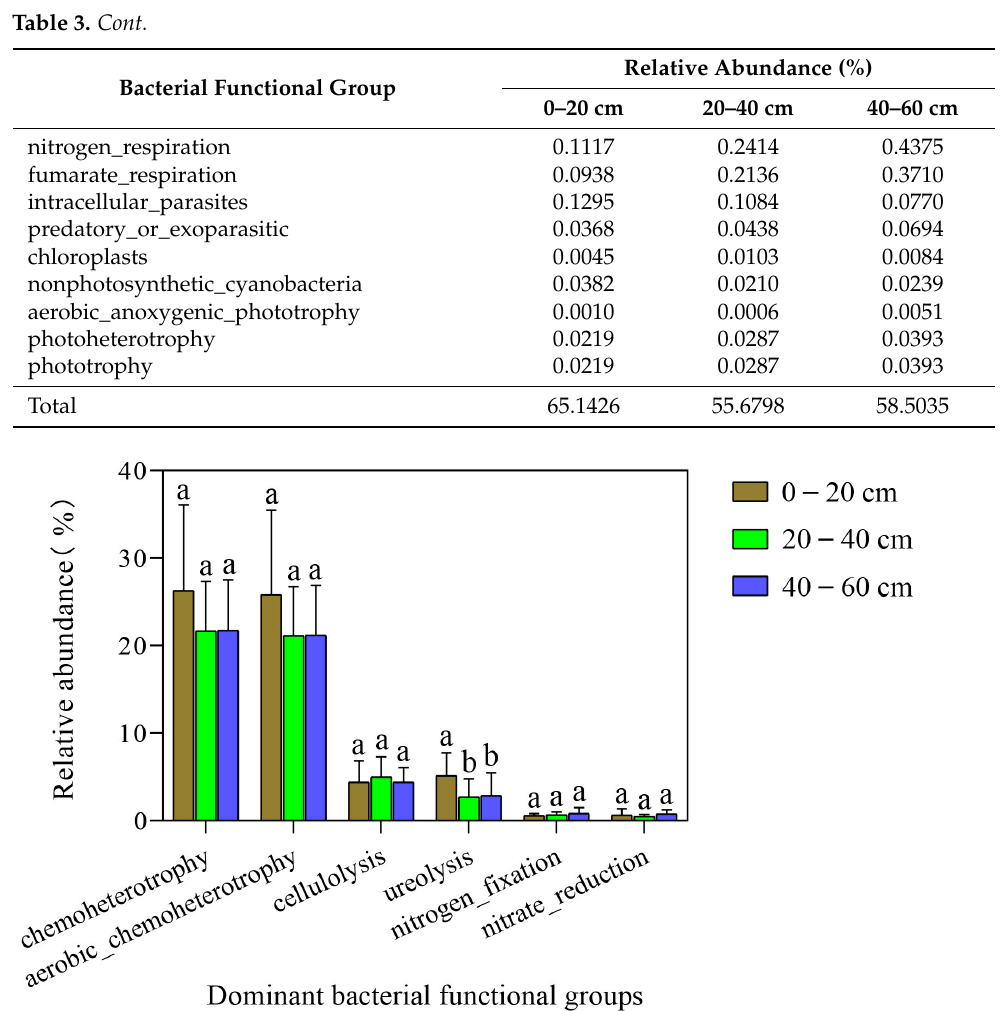
Figure 6. Comparison of relative abundance of the six dominant bacterial functional groups in soil profiles of native tree plantations. Different lowercase letters represent significant differences among different soil layers at 0.05 level. Pearson correlation analysis further showed that soil physicochemical properties had different effects on the dominant bacterial functional groups in each soil layer (Figure 7). In the topsoil, chemoheterotrophic and aerobic chemoheterotrophs were significantly posi- tively correlated with soil TP ( p < 0.05), and cellulolysis was significantly positively corre- lated with soil pH and SOC ( p < 0.05) (Figure 7A). In the middle layer, chemoheterotrophic, aerobic chemoheterotrophic, and nitrate reduction were significantly positively correlated with SOC ( p < 0.05); nitrate reduction, nitrogen fixation, and urea hydrolysis were sig- nificantly positively correlated with soil NH 4+ -N ( p < 0.05); and nitrogen fixation was significantly negatively correlated with NO 3 − -N ( p < 0.05) (Figure 7B). Subsoil nitrogen fixation was significantly and positively correlated with AP ( p < 0.05) (Figure 7C). Overall, soil pH, SOC, NH 4+ -N, NO 3 − -N, TP, and AP were the dominant factors affecting the dominant functional groups of the bacterial communities in the soil